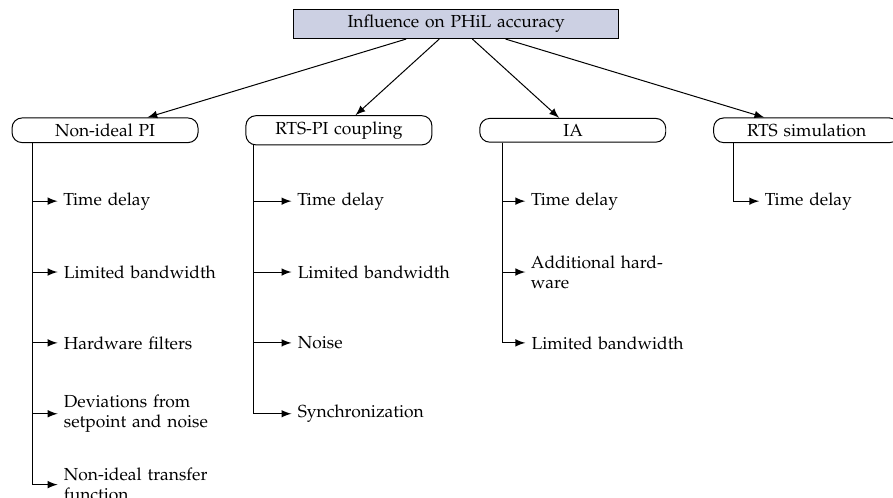
Figure 2. Major accuracy deviations that are introduced in a system through PHiL